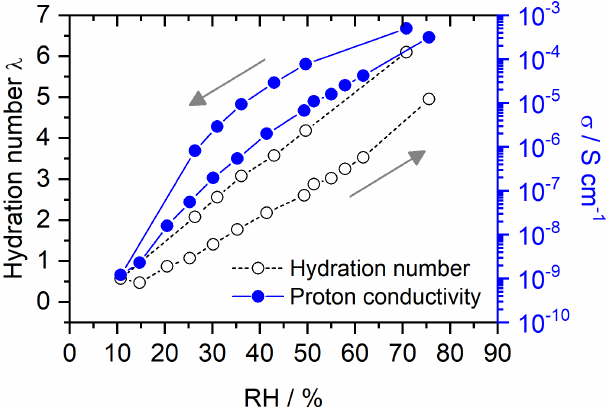
Figure 8. Hydration number λ and proton conductivity σ of SPEEK (DS = 0.9) at 30 ◦ C.